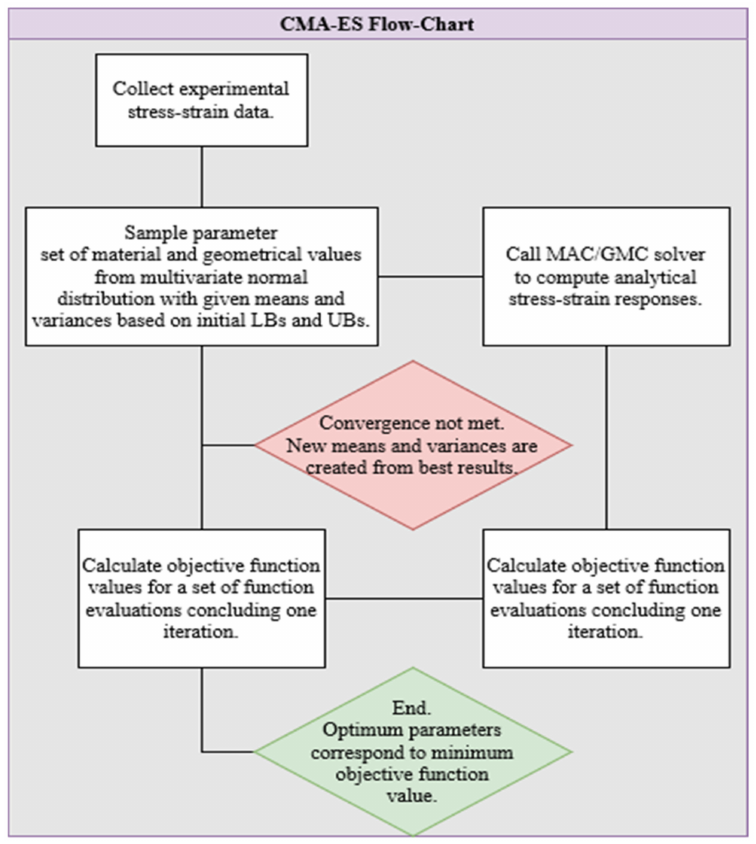
Figure 4. A flow diagram of the applied CMA–ES model update